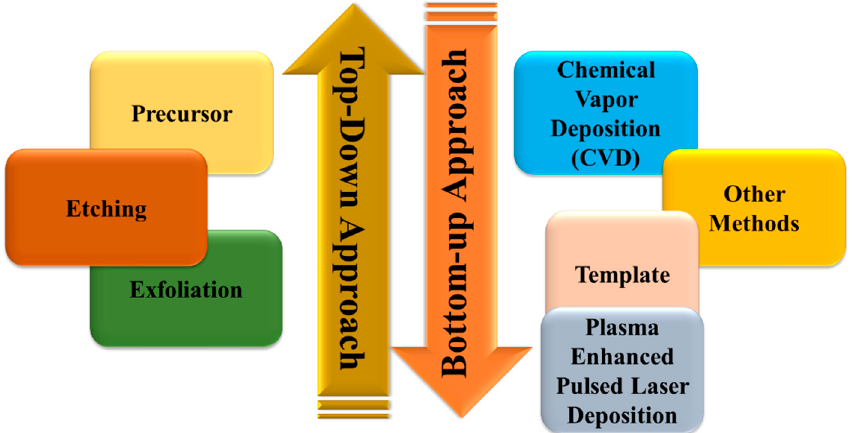
Figure 2. Fabrication methods of MXene by utilizing top-down and bottom-up approaches.